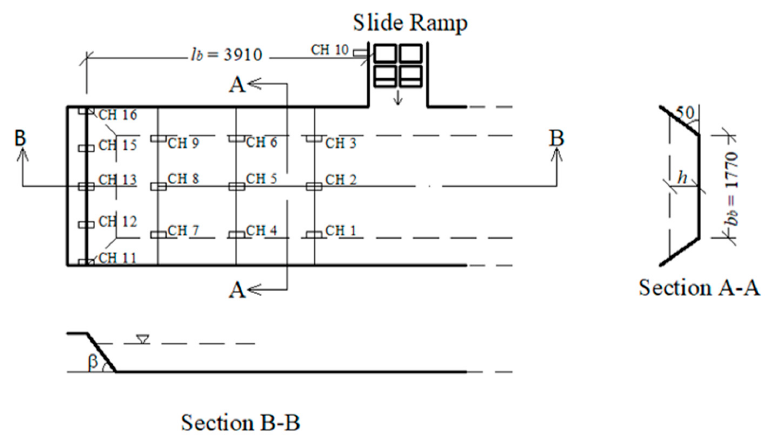
Figure 6. Planar view of sensors placement in the model set-up (measurements in mm).